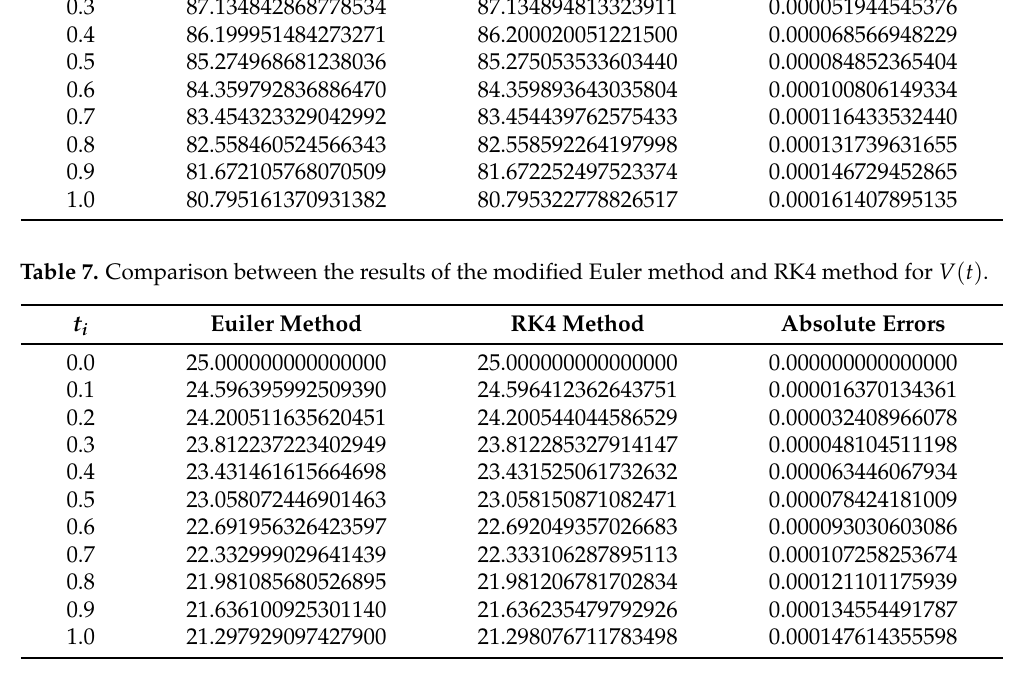
Table 8. Comparison between the results of the modified Euler method and RK4 method for I ( t ) .